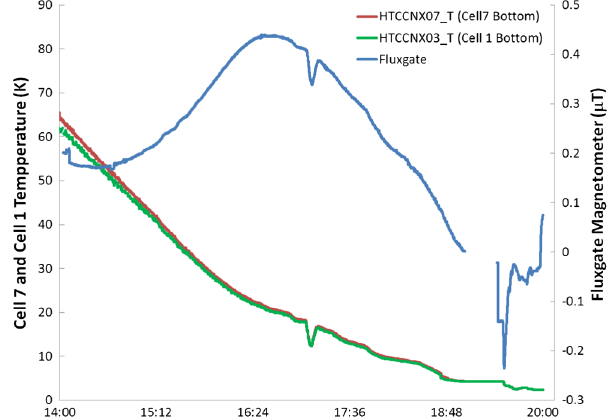
FIG. 1. Magnetic field measurement during initial cooldown of a cavity in a horizontal test (at 3 . 2 K = h around T c ). The flux gate magnetometer was mounted outside the helium tank but inside the second layer of magnetic shielding, measuring only one (arbitrary) component of the magnetic field.